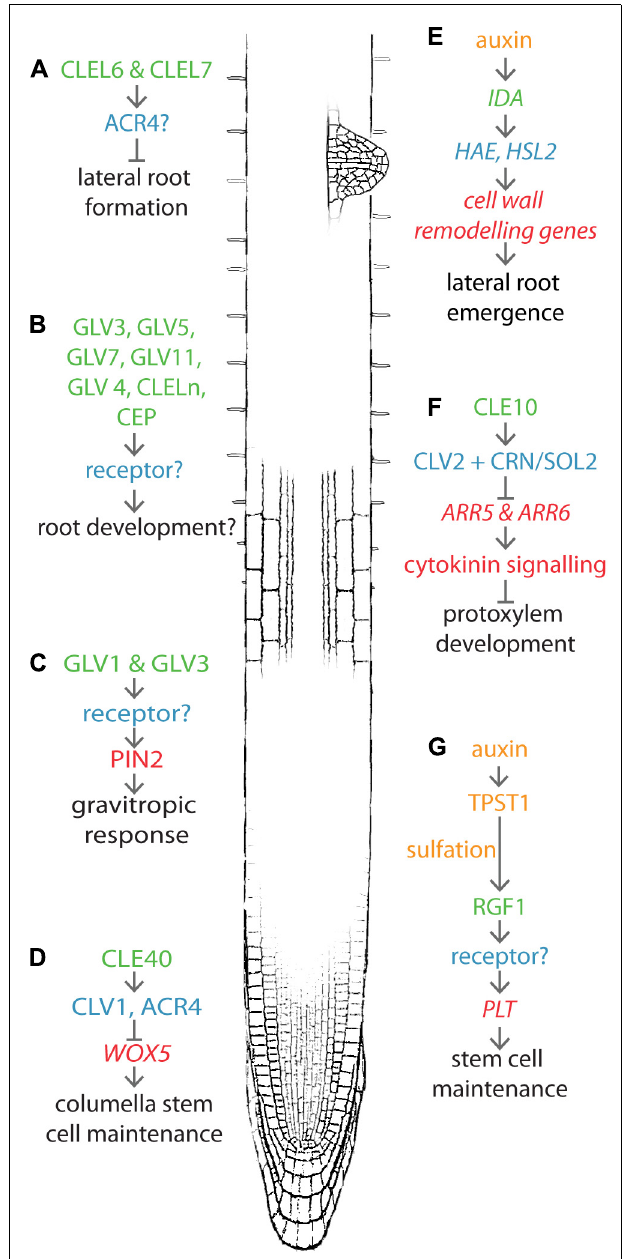
FIGURE 1 | Recent advances in peptide-mediated regulation of root development. CLE, RGF/GLV/CLEL, IDA, and CEP peptides are involved in several aspects of root development including lateral root formation (A), (B), (D), (E) , protoxylem development (F) , stem cell maintenance (G) , and gravitropic response (C) . Known pathways discussed in this review are shown near their approximate location in the root. Peptides are indicated in green text, receptors in blue. Upstream processes are yellow and down- stream processes are red. Developmental output is indicated by black text.